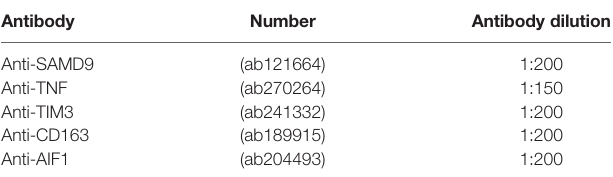
TABLE 5 | Detailed antibody